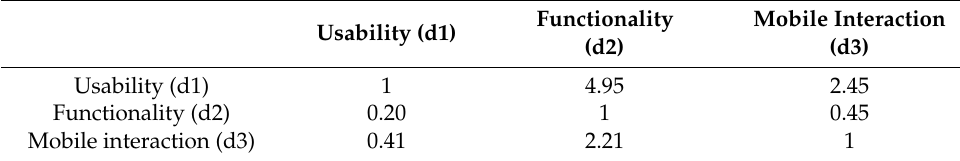
Table 1. Pair-wise comparison matrix of the main dimensions.